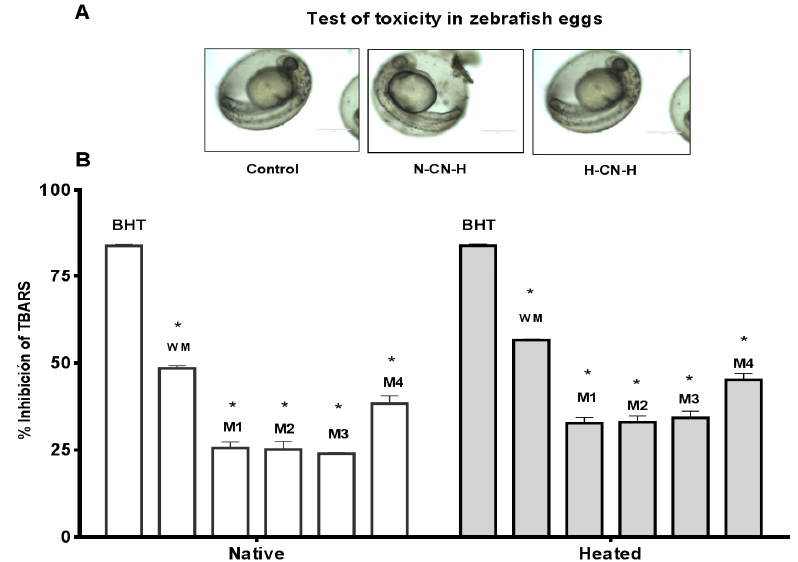
Figure 4. ( A ) Antioxidant activity of casein hydrolysates at concentration of 0.4 mg/mL.